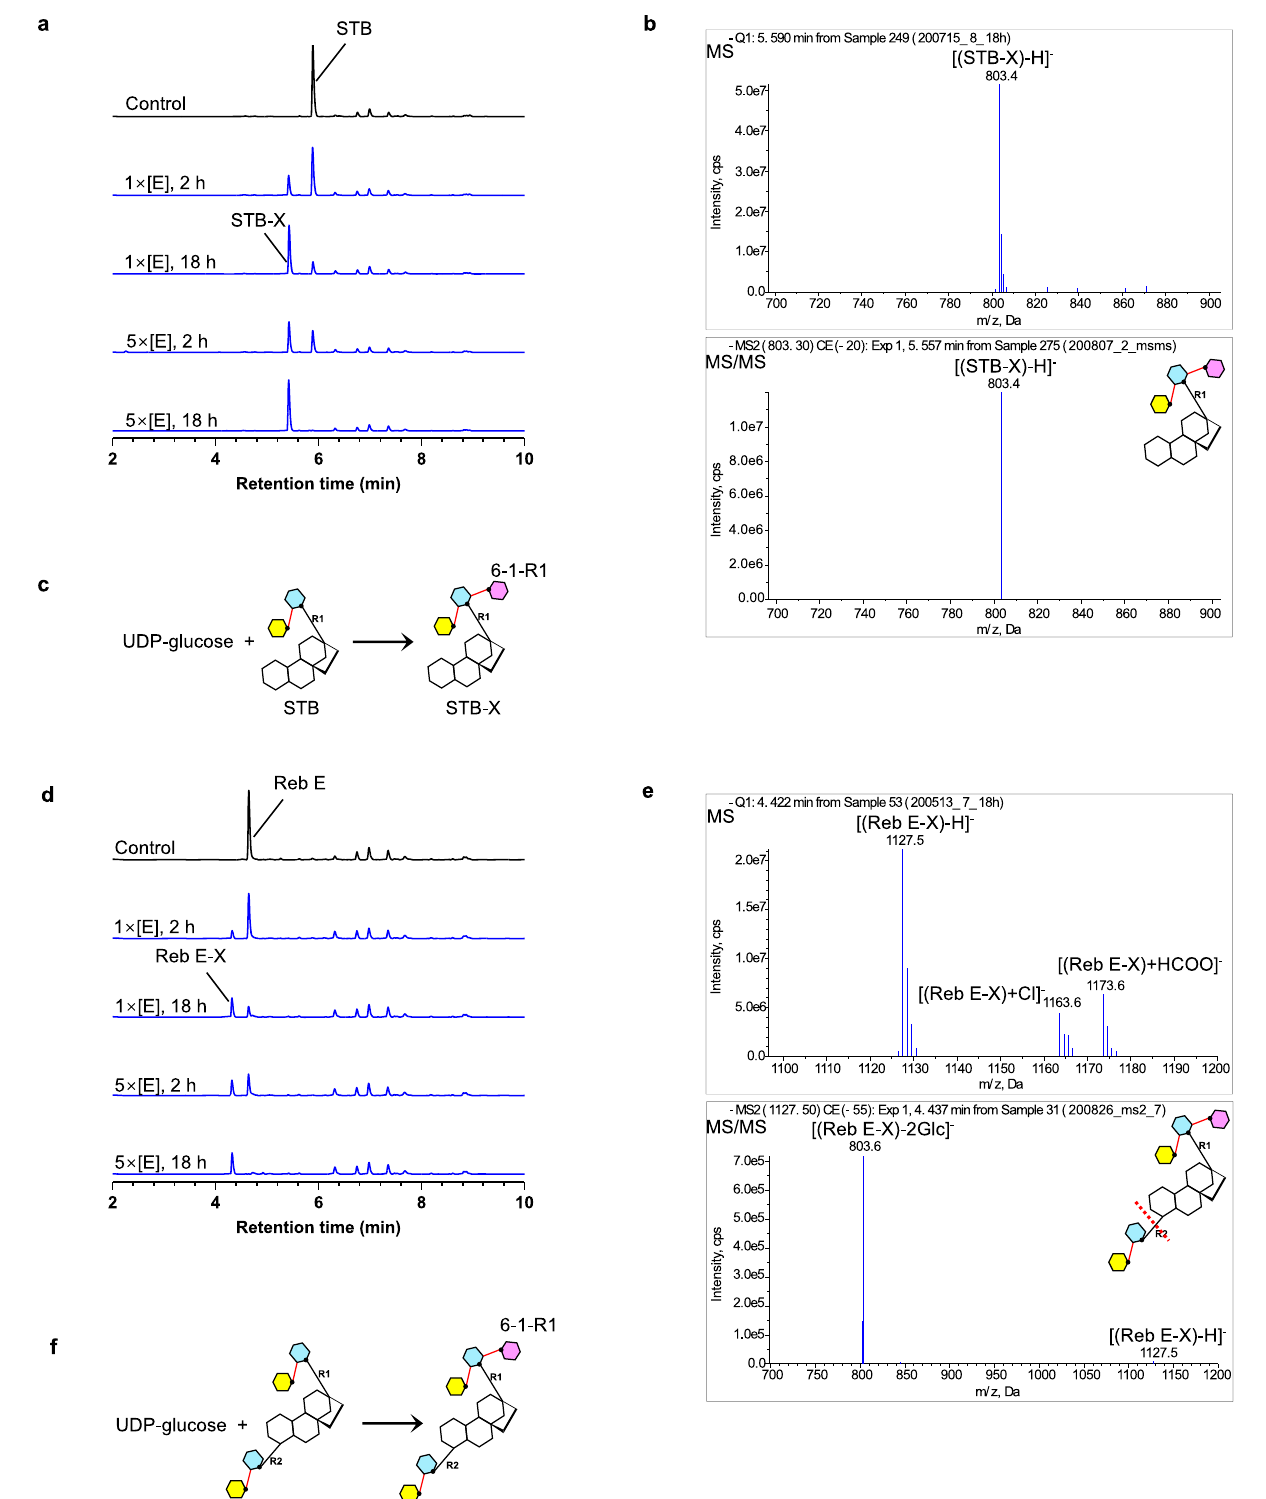
Fig. 4 β (1 – 6) sugar transfer by OsUGT91C1 at the R1 end of steviol substrates STB and Reb E. a , d LC-MS was used to monitor the reaction progress of STB ( a ) or Reb E ( d ) with OsUGT91C1. The HPLC traces represent the 18 h control reaction without the enzyme (black); the incubations for 2 h and 18 h with the enzyme at 0.15 mg ml − 1 ; repeated with the enzyme (5x) at 0.75 mg ml − 1 (blue). The yields of the products are related to the enzyme concentration and the reaction duration, consistent with enzymatic-catalyzed reaction. b , e Mass spectra of the new peak in LC-MS are consistent with a single glucose mass addition at the R1 end of the molecule. The products are arbitrarily named STB-X ( b ) and Reb E-X ( e ). The main negative derived ions are labeled in MS analyses. The negative parent ions [(STB-X)-H] − with m/z at 803 and [(Reb E-X)-H] − with m / z at 1127 were explicitly isolated and characterized by MS/MS. The insert notes where the ester bond breaks fi rst during MS/MS fragmentation with a red dash line. c , f Reaction schemes catalyzed by OsUGT91C1 on substrate STB ( c ) and Reb E ( f